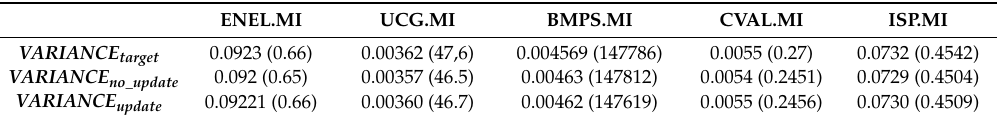
Table 2. ENEL.MI, UCG.MI, BMPS.MI, CVAL.MI, and ISP.MI Variance normalized in [0, 1] while enclosed in bracket corresponding not normalized ENEL.MI